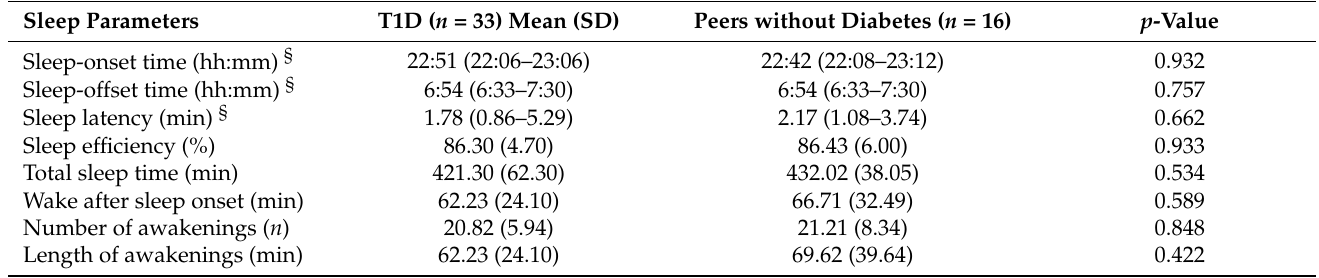
Table 2. Comparison of sleep characteristics between adolescents with T1D and peers without diabetes.